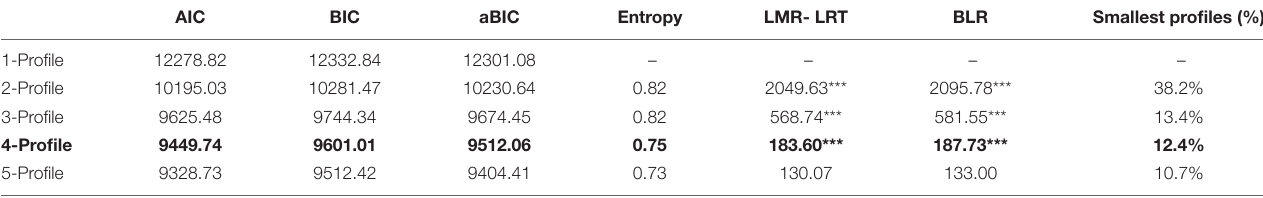
TABLE 2 | The goodness of fit indices for mental health profiles.